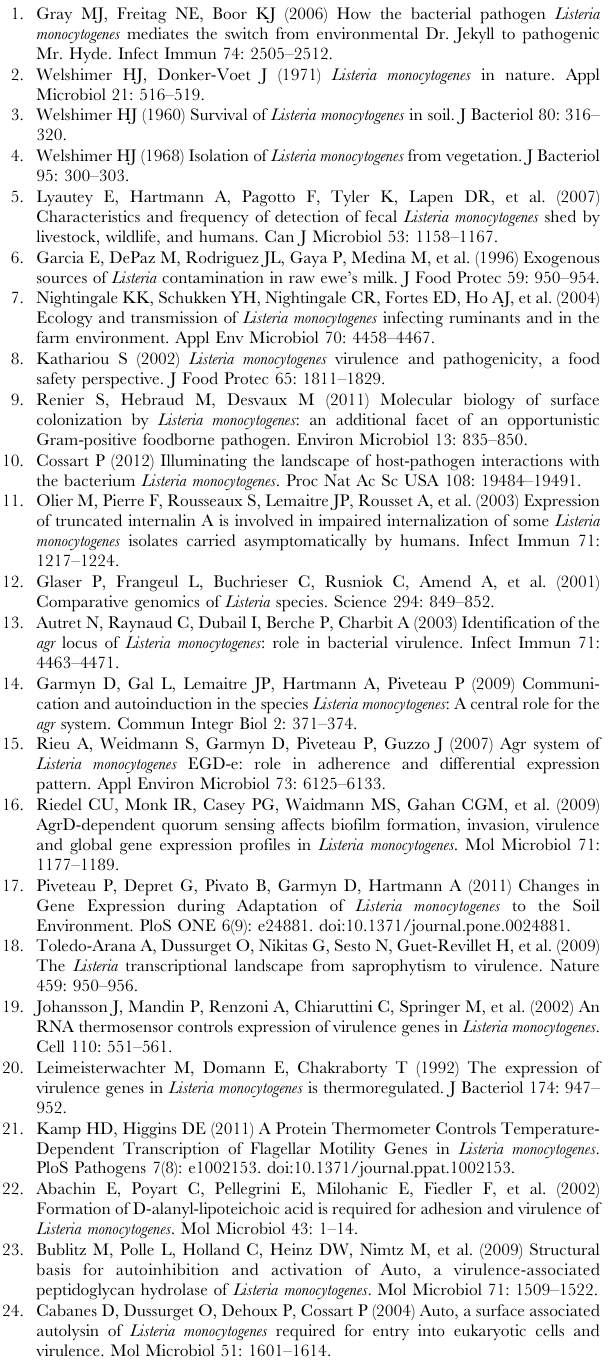
Table S7 List of genes with similar trends at 25 6 C